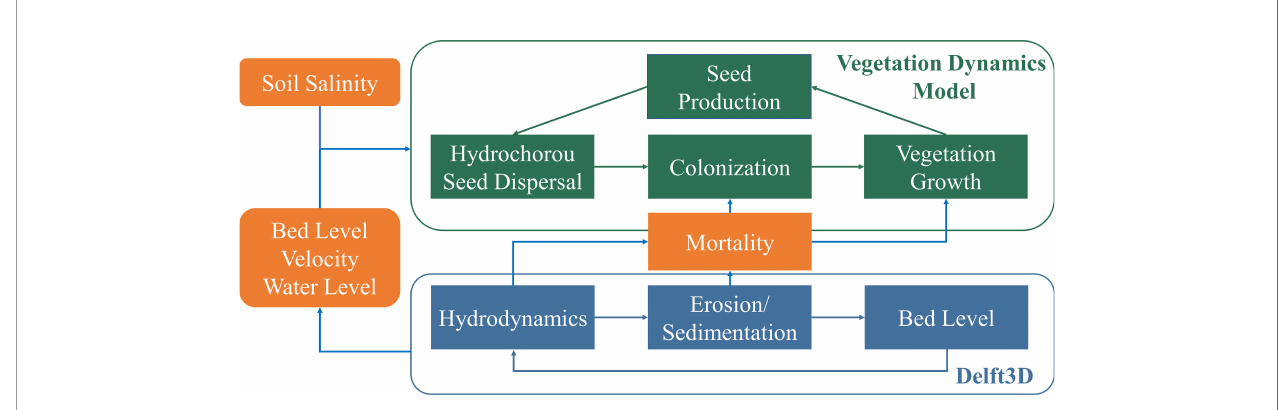
FIGURE 5 | The fl ow-chart of modelling